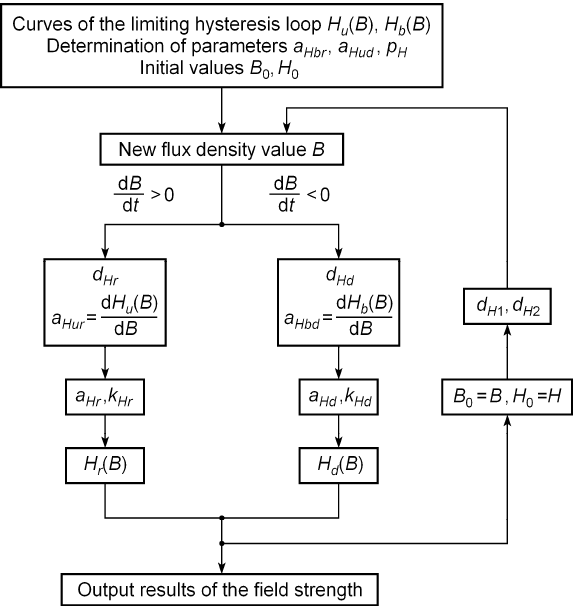
Figure 6. Algorithm to determine changes in the field strength.